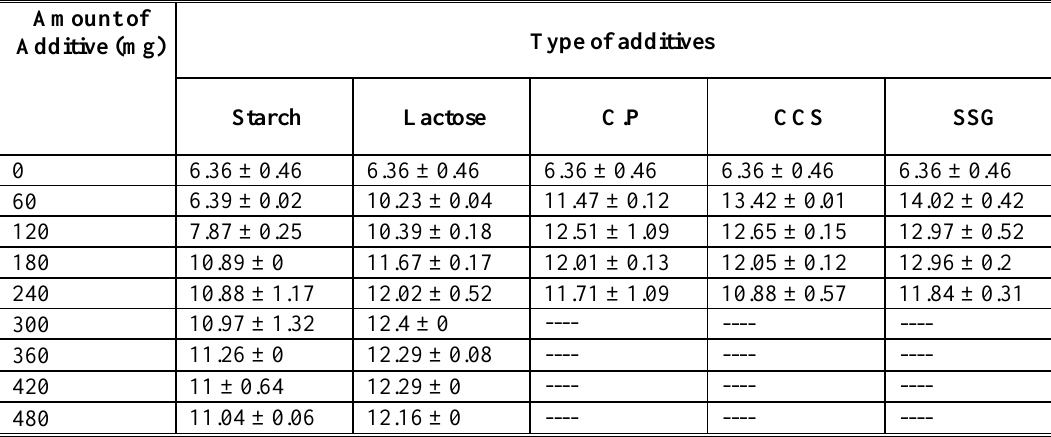
Table 2: Effect of type and amount of additives on the solubility of piroxicam (mg/50 ml) at 37°C in 0.1 N HCl